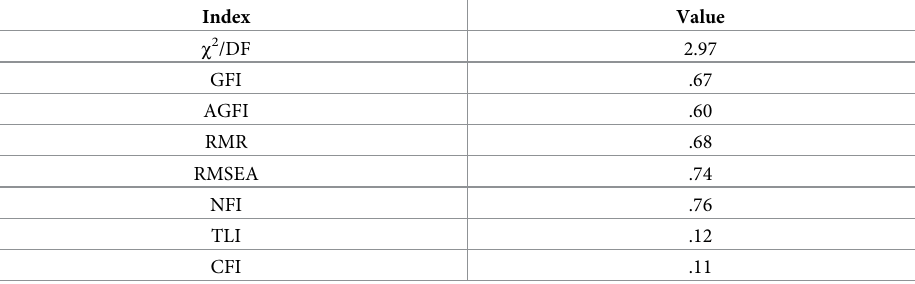
Table 2. Goodness-of fit indices for the HBQOL factor model for the current